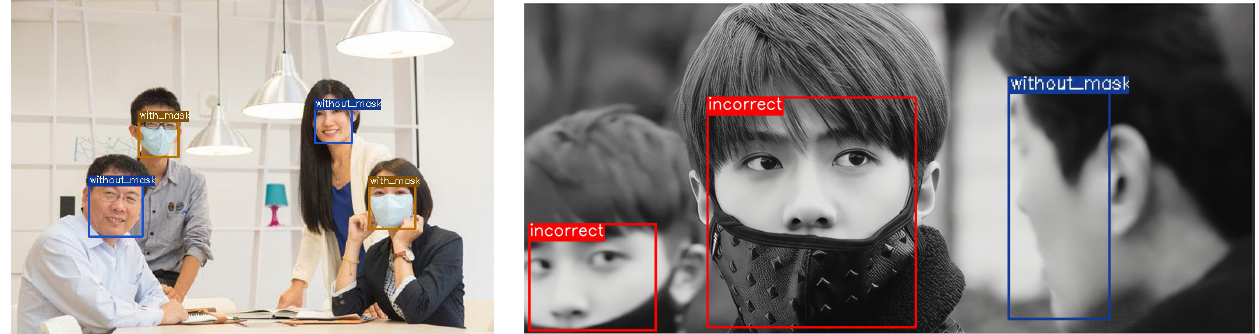
Figure 7. Examples within the dataset.